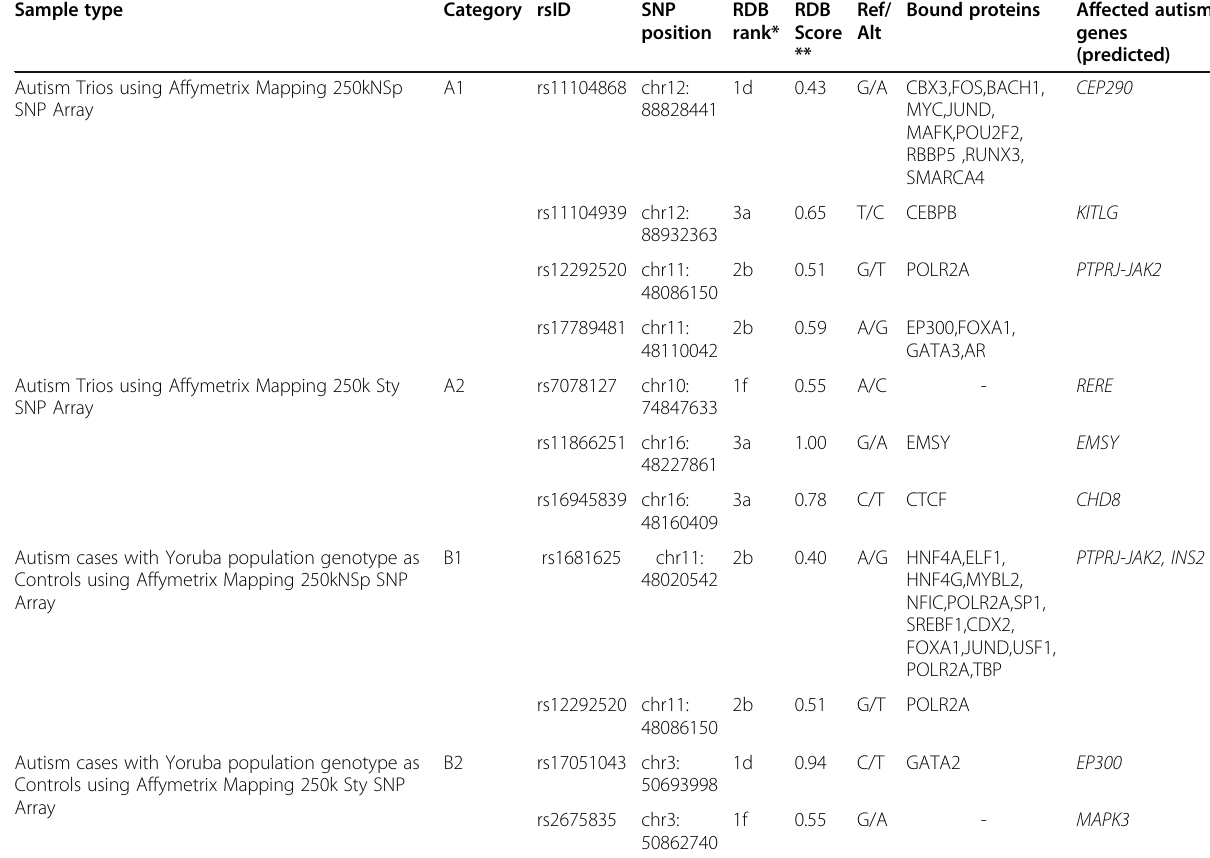
Table 2 eQTL analysis for the homozygous regions identified specific to autism across samples Sample